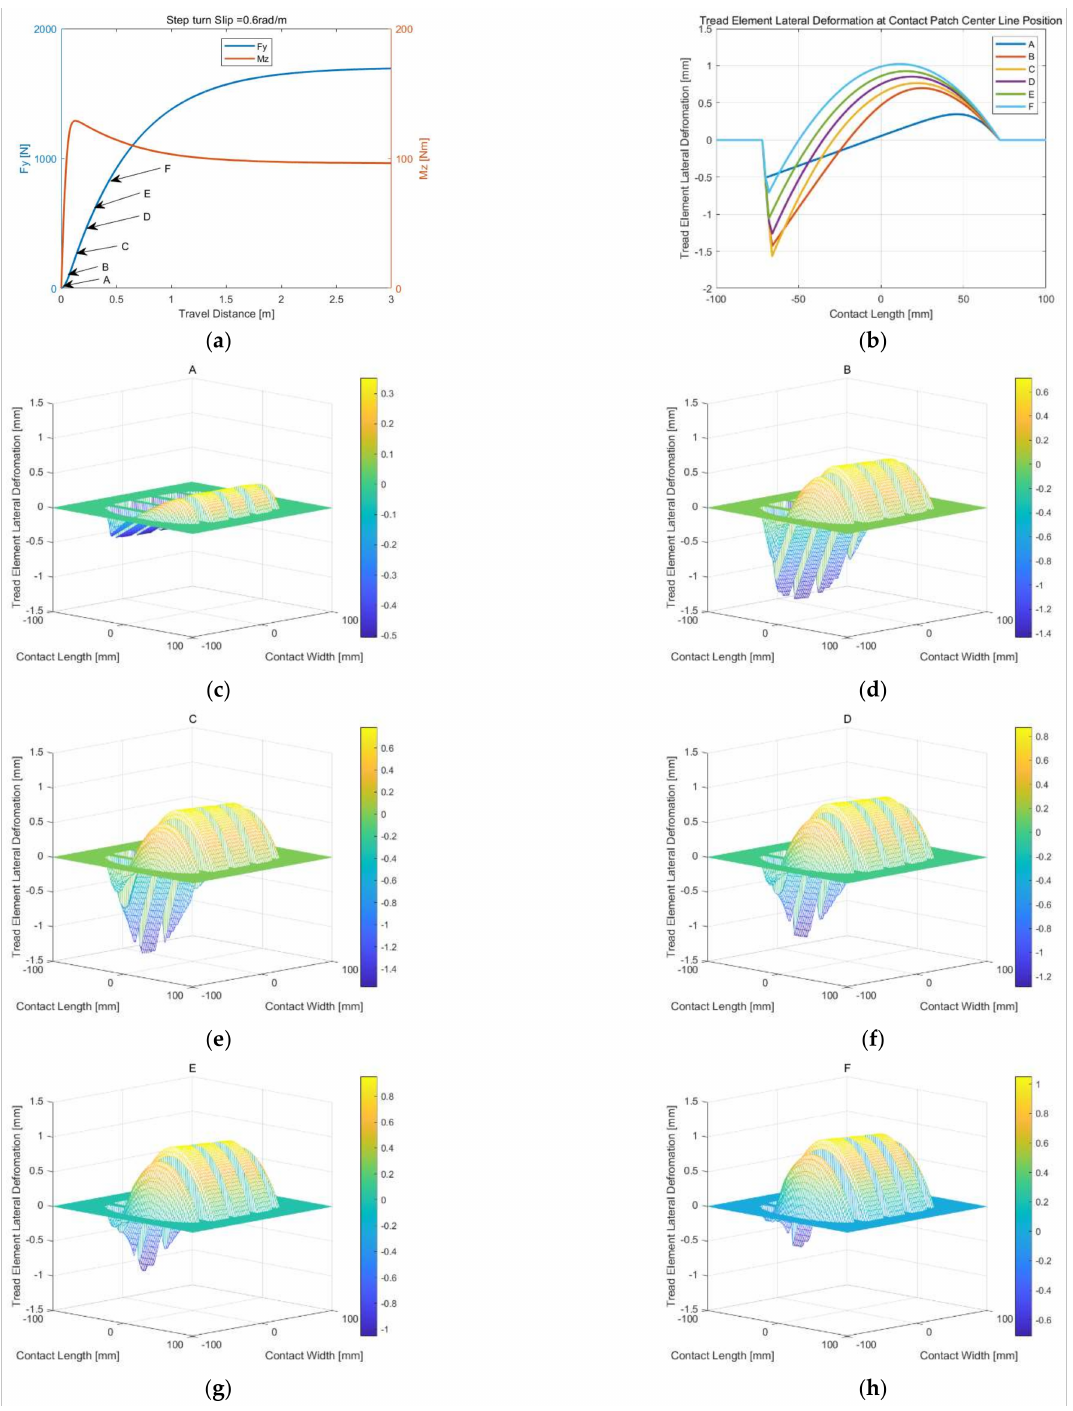
Figure 20. Lateral deformation of the tread element at different traveling distances under the step turn slip input. ( a ) Response of lateral force and aligning moment. ( b ) Deformation of the tread element at the contact patch center line under different travel distance. ( c ) Deformation of the tread element at A position. ( d ) Deformation of the tread element at B position. ( e ) Deformation of the tread element at C position. ( f ) Deformation of the tread element at D position. ( g ) Deformation of the tread element at F position. ( h ) Deformation of the tread element at E